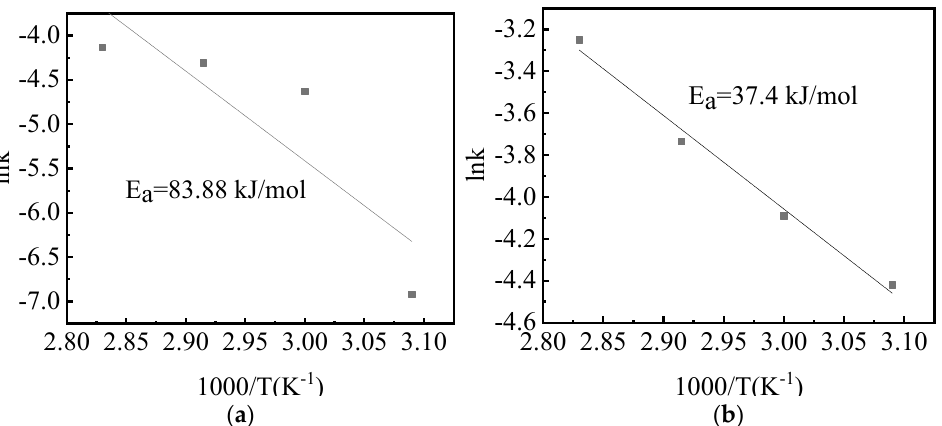
Figure 9. Arrhenius diagram of the sample. ( a ) Mechanically inactivated sample; ( b ) Mechanically activated samples.